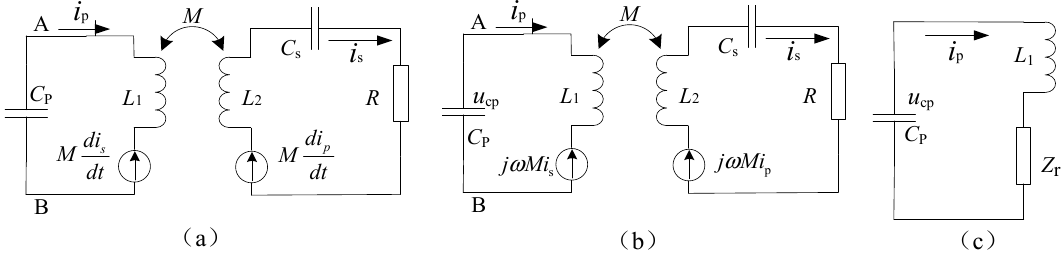
Figure 4. Circuit models in the free resonance state stage: ( a ) simplified circuit model; ( b ) equivalent circuit model under sinusoidal condition; ( c ) equivalent circuit of the primary.